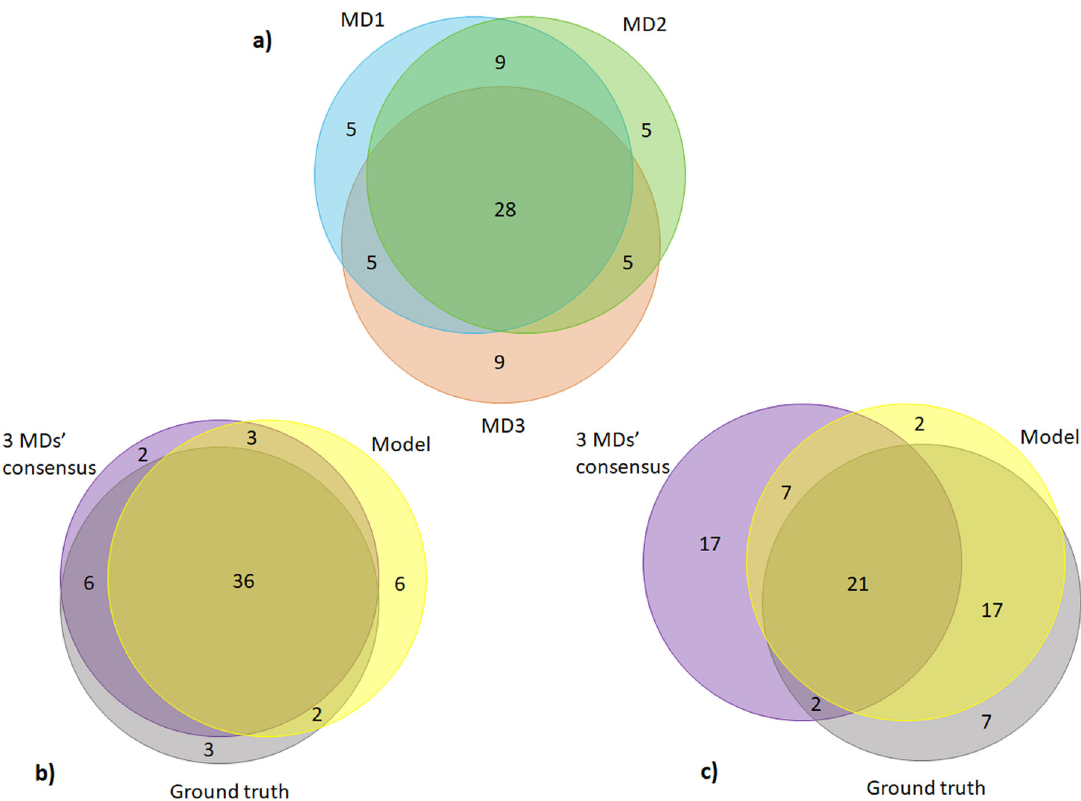
Fig. 2 Overlap of agreement between MDs, the model and the ground truth. Panel a shows the overlap of agreement between the three MDs on decisions of whether to fl ag or not to fl ag a particular case. Panel b shows the best-case scenario from the PR and c shows the worst- case